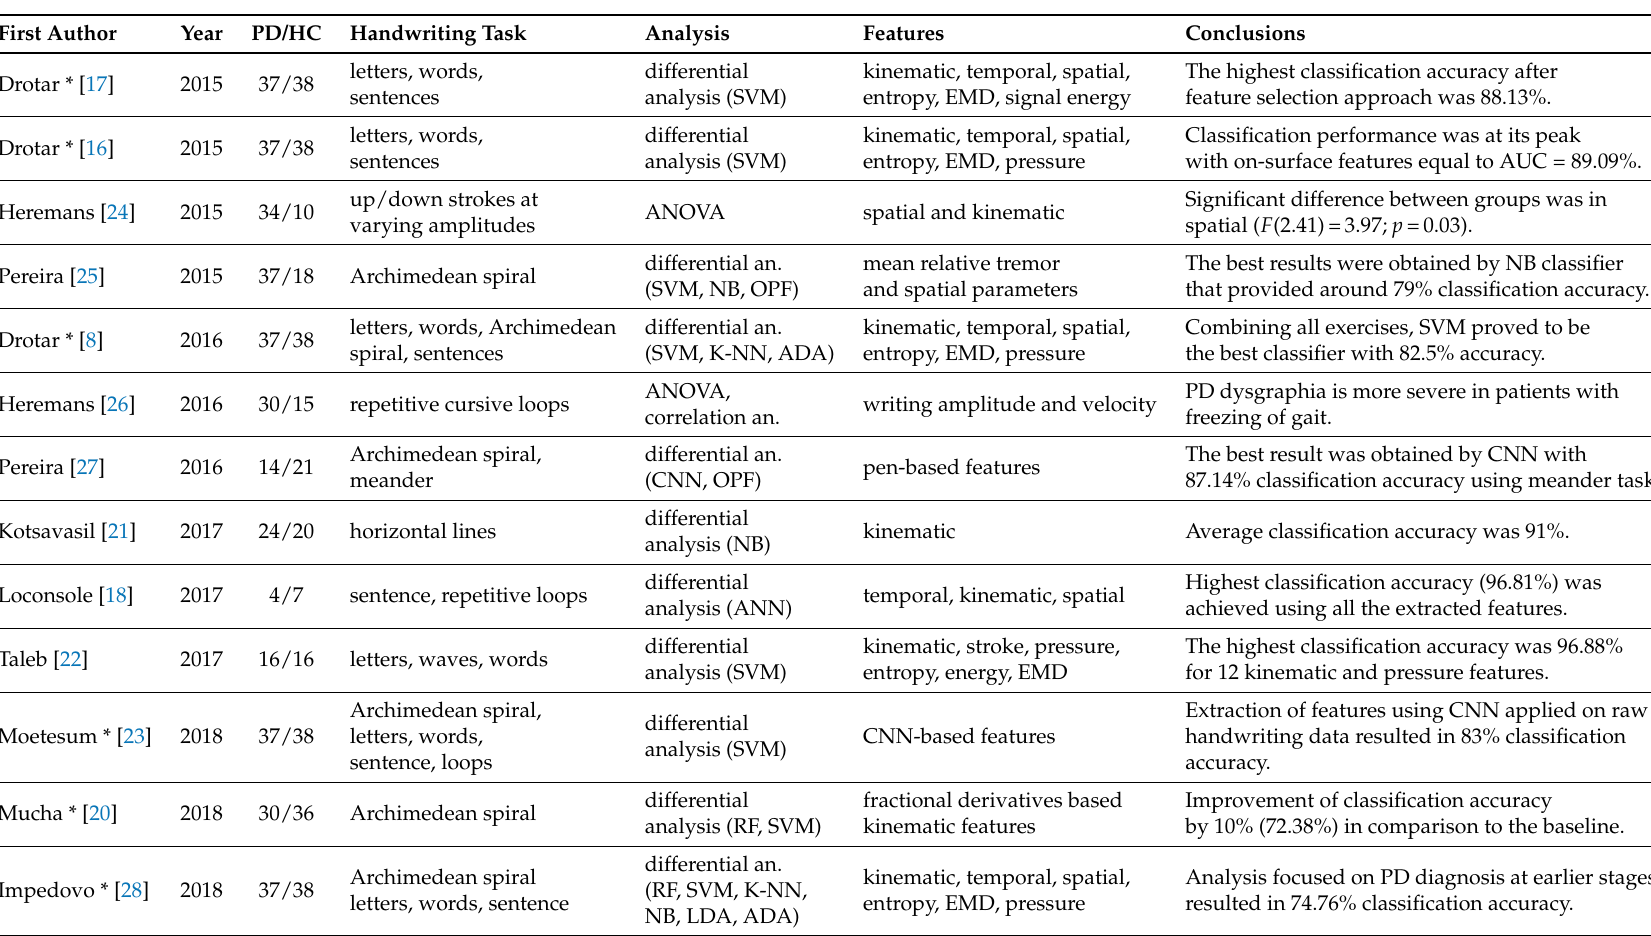
Table 1. Overview of related works focused on computerized analysis of Parkinson’s disease (PD)